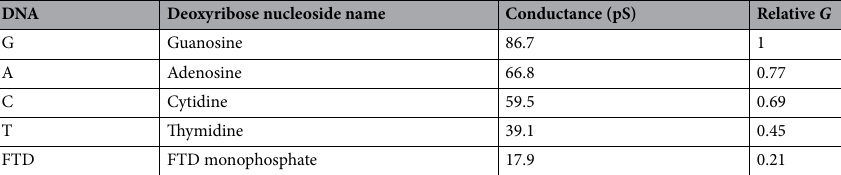
pared three experimental groups as following: cells without FTD exposure (P), cells with 1 month FTD exposure (F1), and cells with 5 months FTD exposure (F5). The experimental setup (Fig. 1a) involved lysing and extracting DNA in the first step. In the second step, the binding regions of p53 were captured and purified by the probe DNA complementary to the consensus p53-binding sequence (Table 1). From previous reports 23 , the consensus binding region of p53 is known to be resembles thymidine (dT) (Fig. 1b), it is expected that FTD substitutions potentially occur at the number sixth position T (#6:T) and sixteenth position T (#16:T) within the consensus-binding region. In the third step, the conductivity of each captured DNA is measured by sequentially reading across individual single-nucleotides with nanofluid integrated nanogap devices (Fig. 1), in which the nanofluid can strongly confine nucleotide transloca- tion, resulting in the straight-guiding of the nucleic acid molecules into the fluid region under DC voltage across the gap-electrode. The resulting conductance–time profiles represent the conductance sequence of each nucleo- tide in synthesized oligonucleotides translocating through the gap-electrodes (SI: S1 and Fig. S1). In the fourth step, by using a Phred base-calling method (SI: S2 and S3), we performed signal analysis, including picking-up and base-calling for each conductance–time profile based on the conductivity of all kinds of potential nucleotides including FTD mono-nucleotide and determined the sequences of the oligonucleotides translocating through the gap-electrodes. The conductance values order was as follows: dG (87 pS) > dA (67 pS) > dC (60 pS) > dT (36pS) > FTD (18 pS) (Table 2) 15,17 . In the final step, these determined sequences were mapped by assembling against an original sample sequence (SI: S3). Based on this mapped sequence, the conductance profiles were obtained and the FTD conversion rate in the sample nucleotide is evaluated, especially for each thymine site in the sample nucleotides (SI: S7). First, we obtained conductance signals from the RKO cell line cells for each experimental group. Each signal was reassembled based on the p53-binding motif sequence (5 ′ -AGA CAT (or F) GCC CAG ACA T (or F) GC CC-3; F = FTD) to obtain a conductance plot. Figure 2a shows conductance plots for DNA extracted from RKO cancer cells (F5 sample), while conductance plots are shown for synthesized target non-FTD oligonucleotide tive signals around 0.41 of relative G coexisted with the conductivity of cytidine and around 0.23 of relative G in the thymine position of #6 and #16 (Fig. 2a). According to the conductance table (Table 2), T is 39.1 pS, FTD is 17.9 pS, and the relative conductance with G (86.7 pS) is 0.45 and 0.20, respectively. Based on the conductive